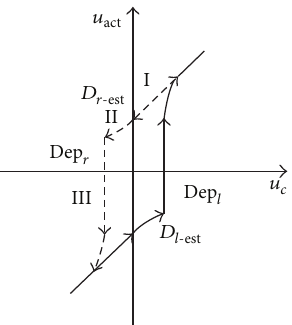
Figure 7: The experimental